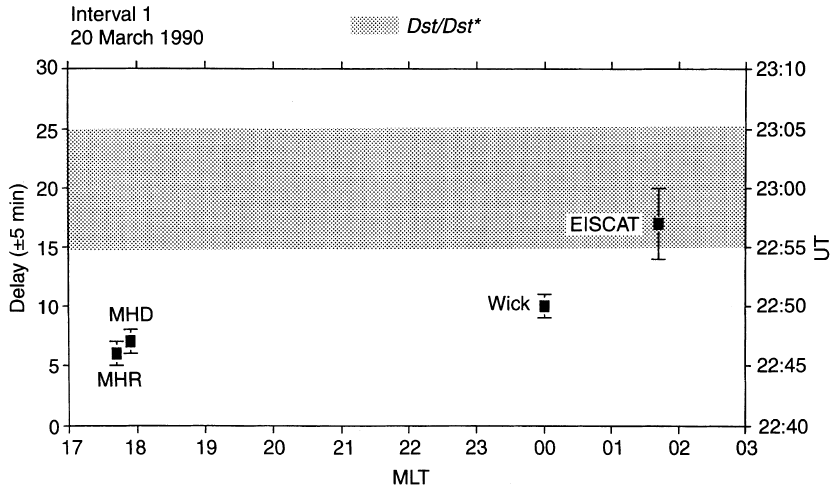
Fig. 10. Ionospheric response times to the southward turning as a function of MLT associated with the SSC at 2240 ((cid:139)1) UT March 20 during interval 1, reproducing the results of Taylor et al. (1994b) and including the response time of Dst / Dst * ( shaded